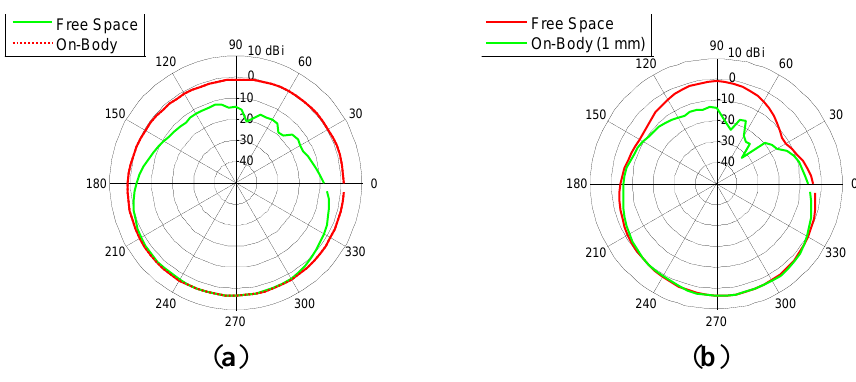
Figure 7. Free space and on-body radiation patterns of the dual band PIFA antenna at 1.9 GHz ( a ) XY plane at 1.9 GHz and ( b ) YZ plane at 1.9